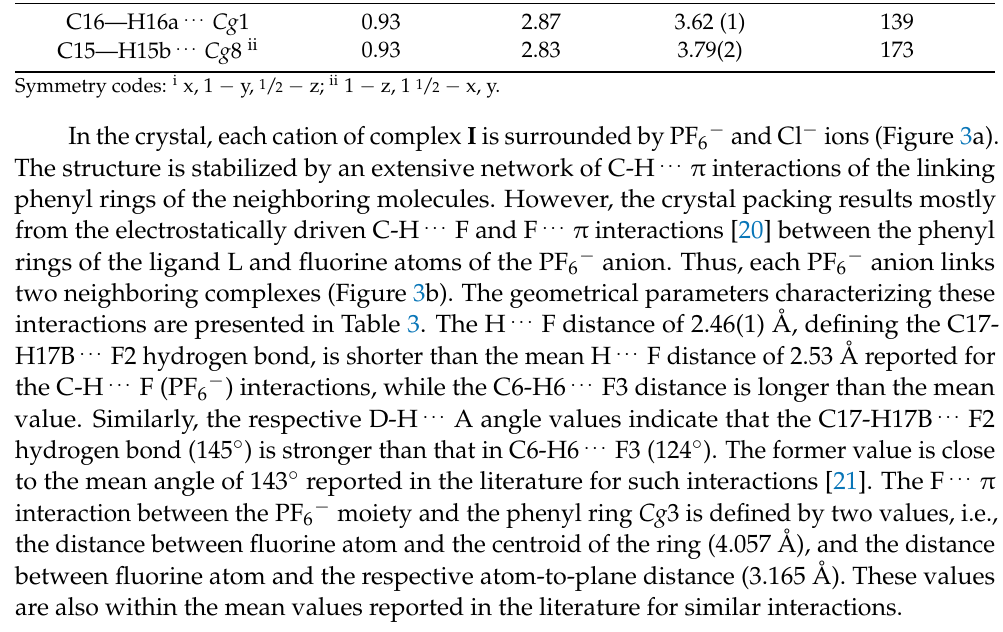
Table 3. Geometrical parameters characterizing the selected intermolecular interactions in structure I.